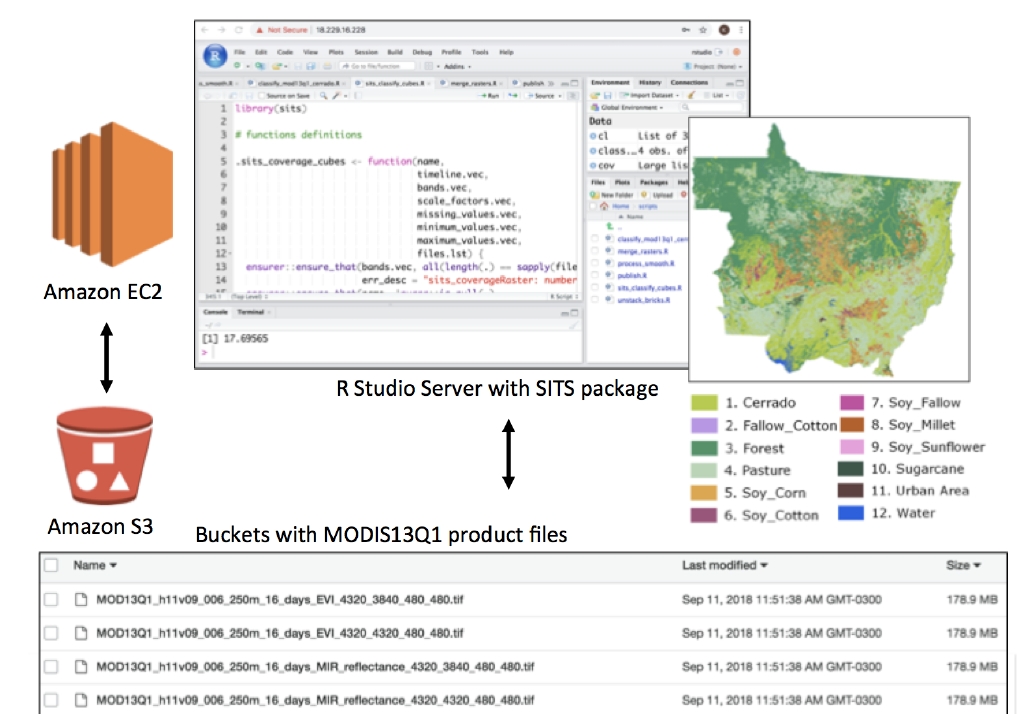
Figure 5: LUCC classification on